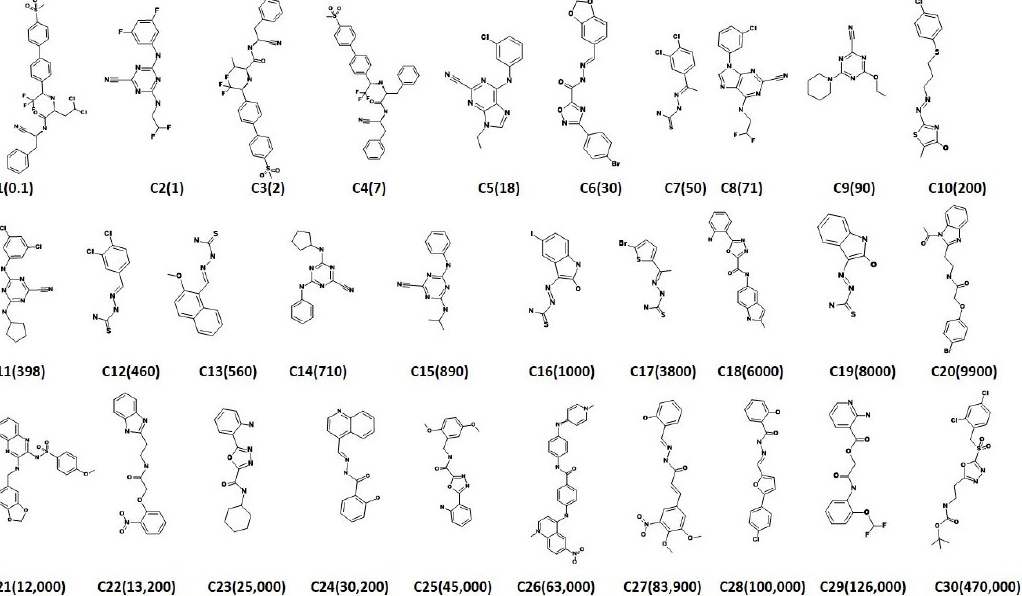
Figure 1. 2D structural representation of 30 training set compounds employed for pharmacophore generation. Their experimental IC 50 (nmol/L) values are expressed in parentheses.